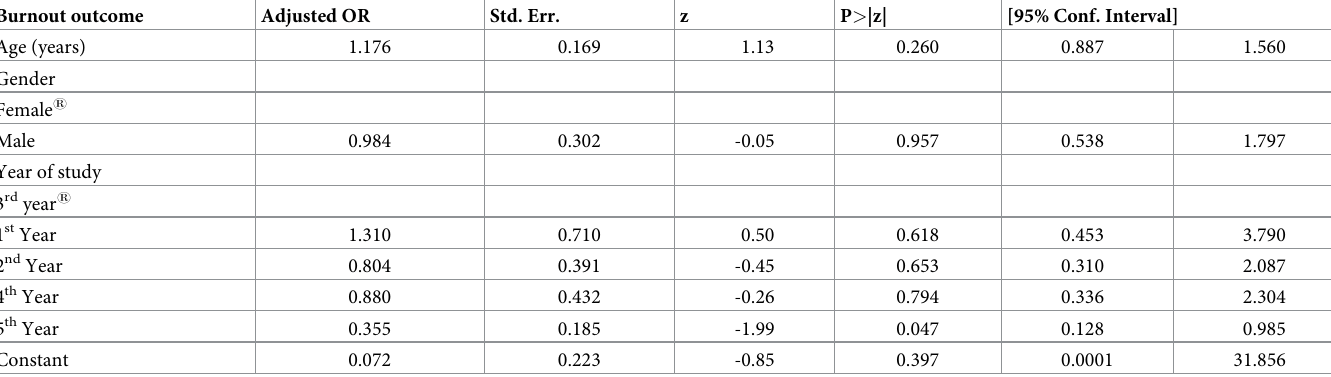
Table 2. Binary logistic regression for the occurrence of burnout. Burnout outcome Adjusted